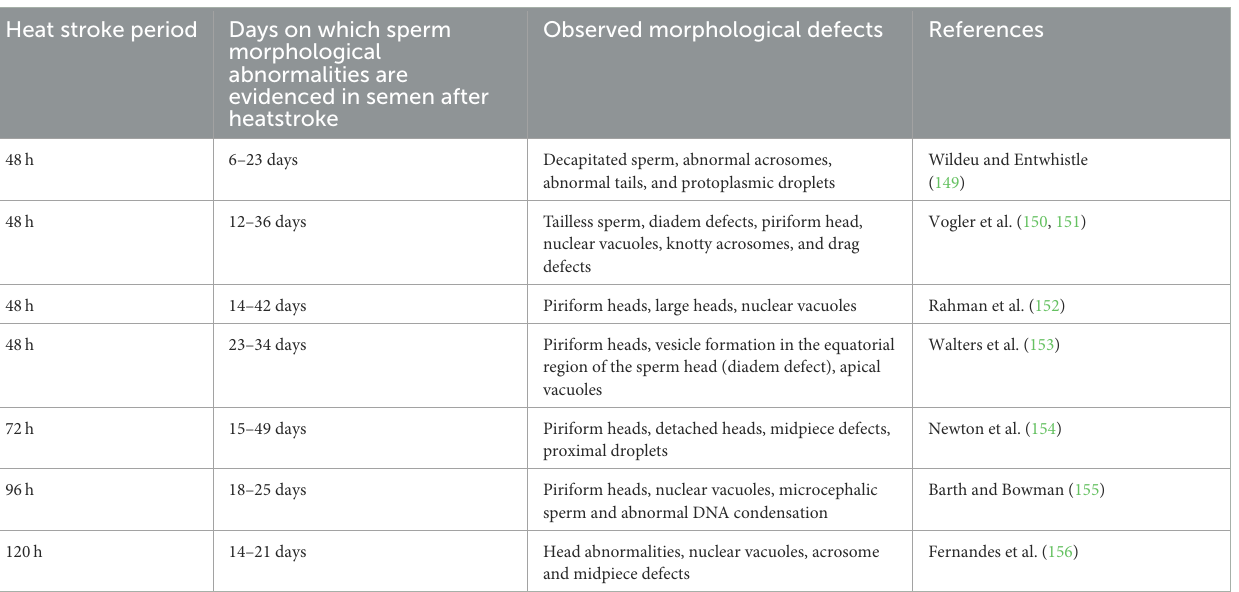
TABLE 5 Morphological defects observed in studies after heat stress due to scrotal isolation in cattle.